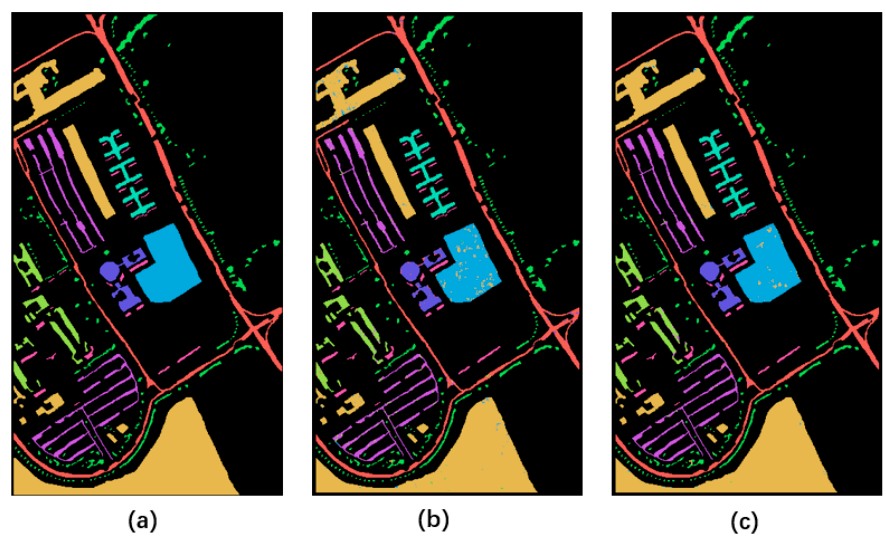
Figure 13. Classification results on the Salinas dataset. ( a – c ) represent category labels of ground truth, classification result on degraded data, and classification result after quality enhancement, re- spectively.